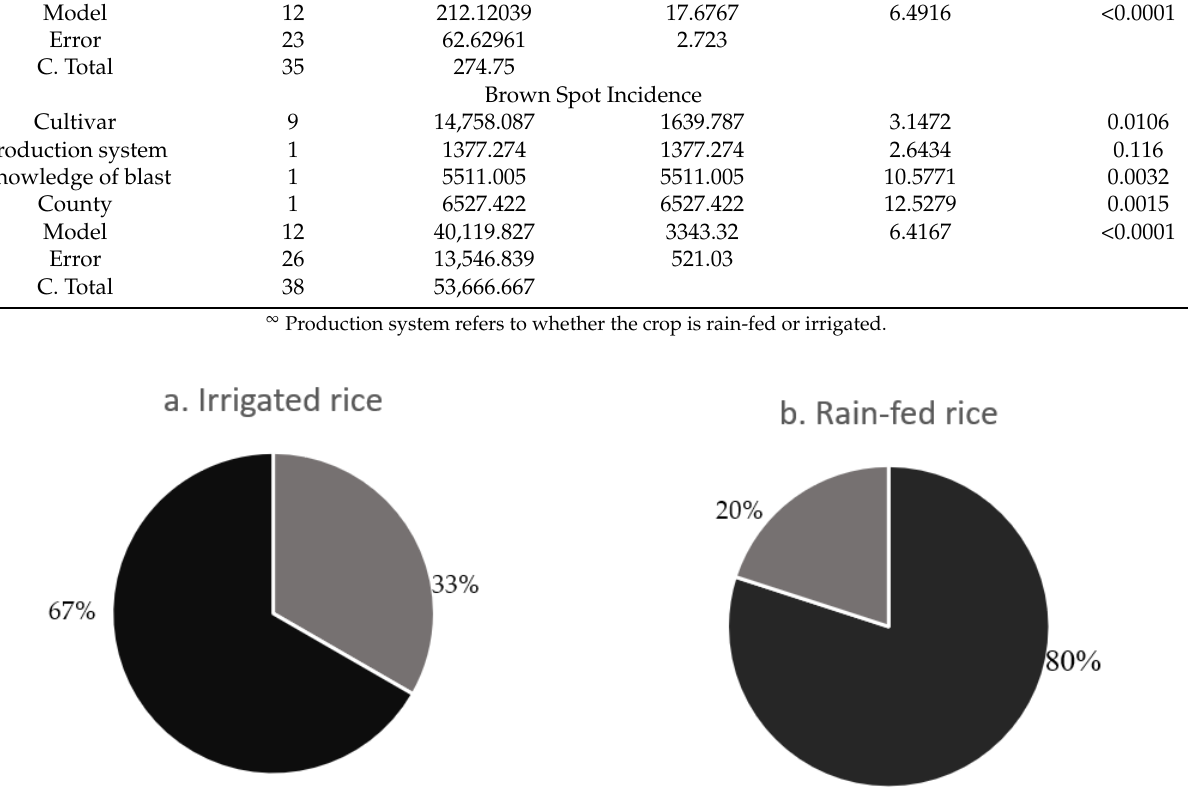
Figure 3. Association between growers’ awareness of rice blast disease symptoms and the incidence ( A ) and severity ( B ) of blast and incidence of brown spot ( C ) disease.